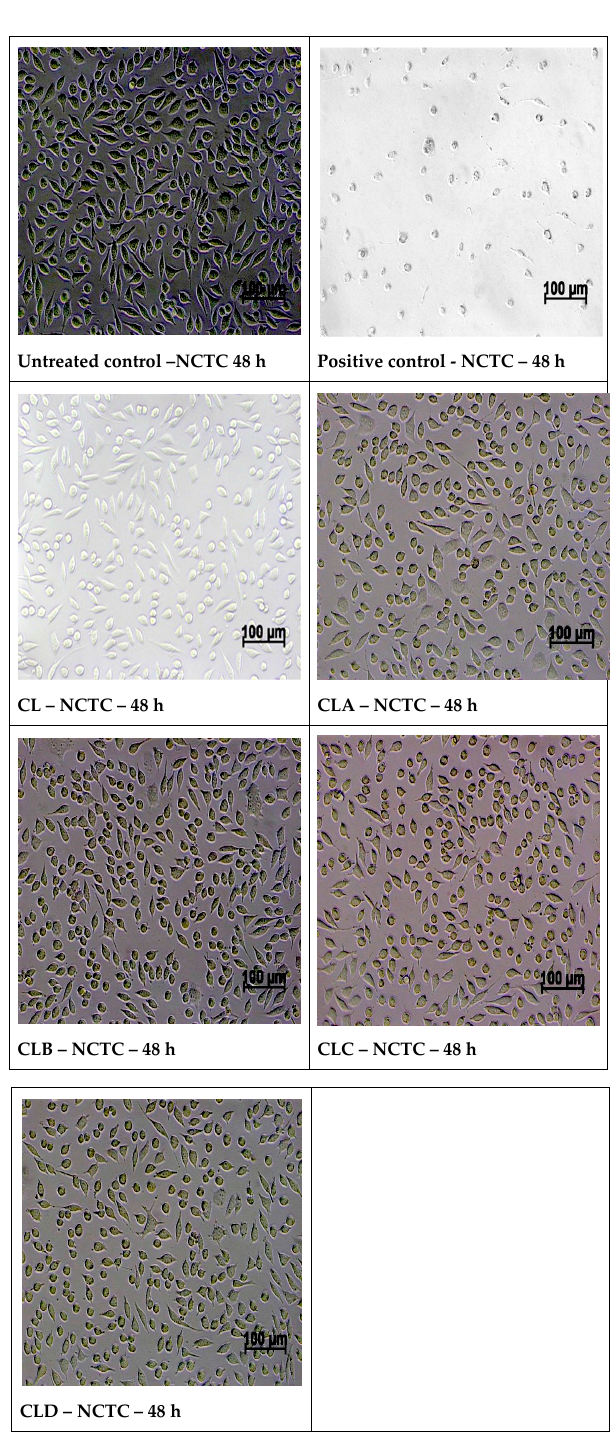
Figure 9. Optical microscopy images of normal NCTC fibroblast cells, after 48 hours of direct contact with nanoparticles samples.